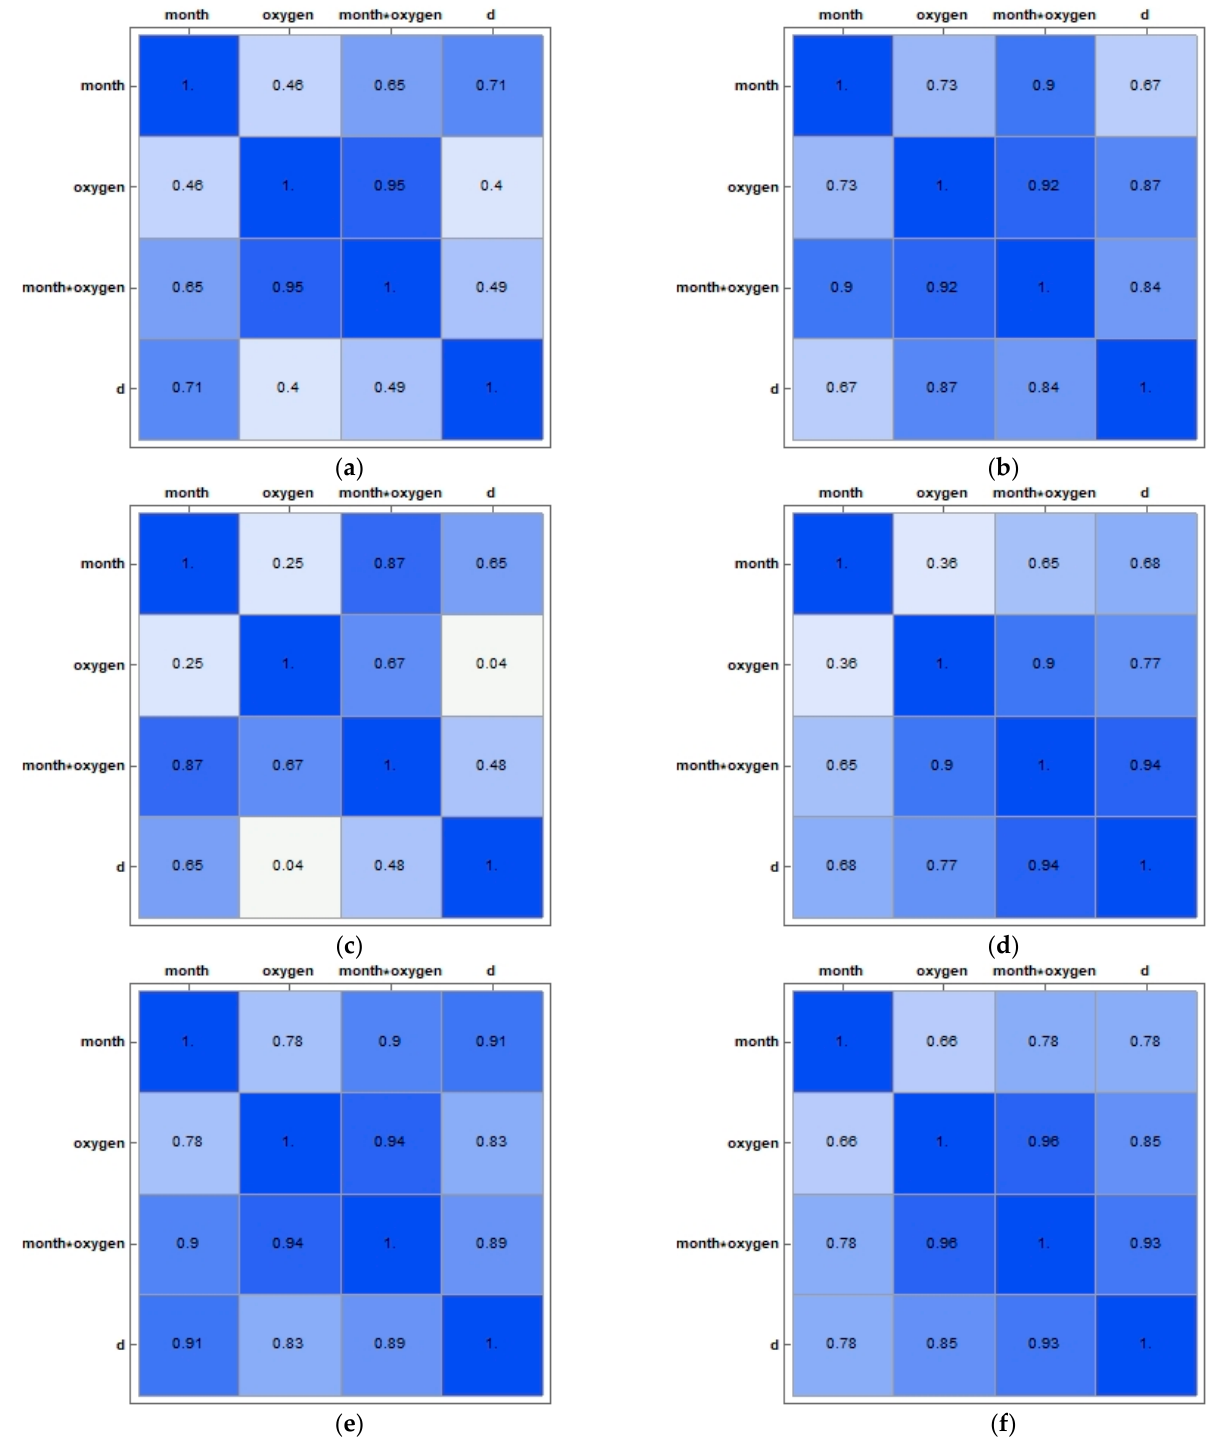
10 of 19 Figure 4. Empirical corrosion depth: Influenced by air on NiTi1 ( a ) and NiTi2 alloys ( b ), influenced by the tide on NiTi1 ( c ) and NiTi2 alloys ( d ), influenced by sea on NiTi1 ( e ) and NiTi2 alloys ( f ).